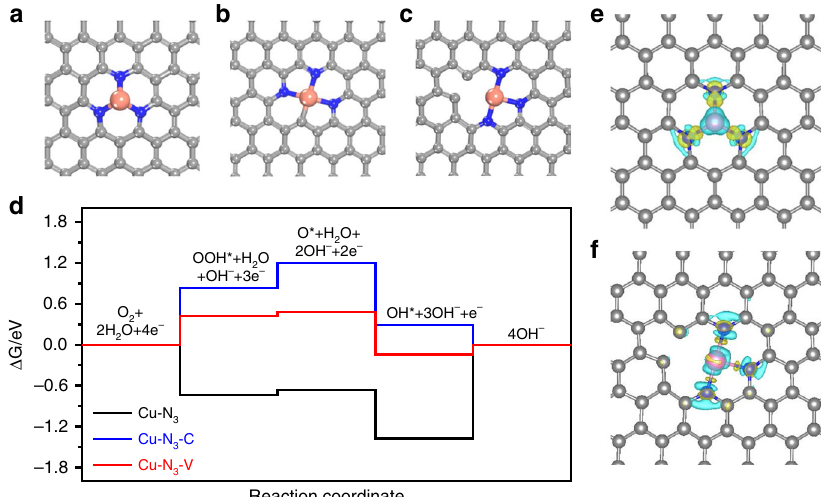
Fig. 3 DFT calculation. Top view of the optimized structures of the models of a Cu-N 3 , b Cu-N 3 -C and c Cu-N 3 -V. Gray, blue and orange represent C, N, and Cu atoms, respectively. d Free energy diagram for ORR process on these three models at the equilibrium potential ( U = 0.40 V vs. NHE or U = 1.23 V vs RHE) at pH = 14. The corresponding charge density difference of e Cu-N 3 and f Cu-N 3 -V, in which light blue and yellow isosurfaces denote a decrease and increase of 0.005 e/Å 3 for electronic density, respectively